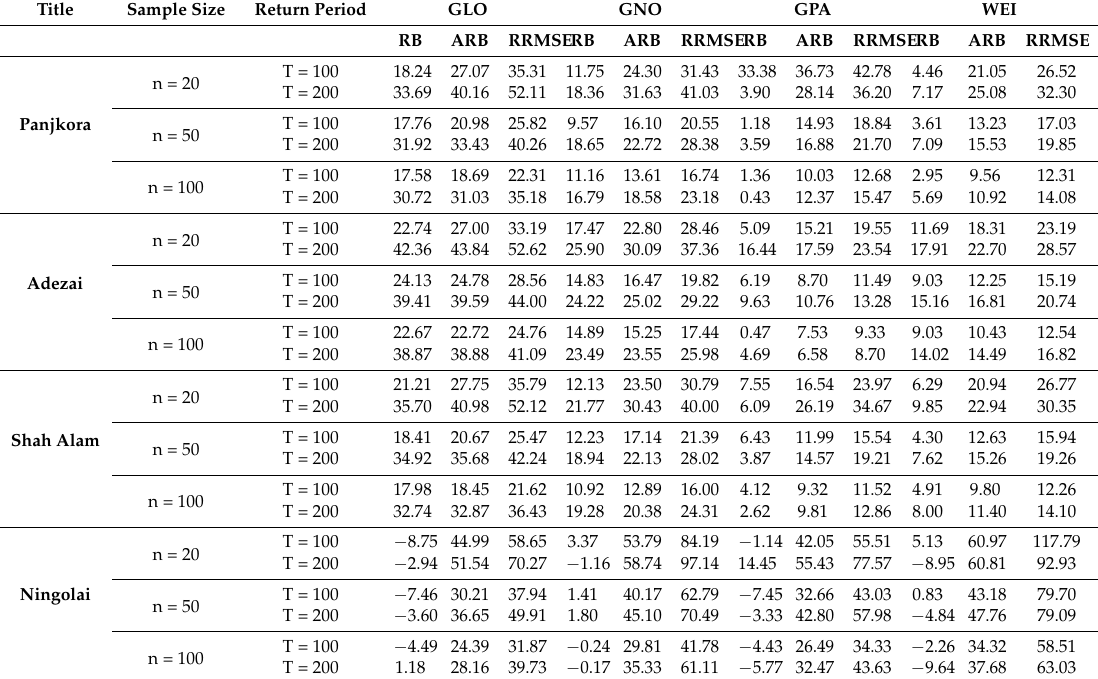
Table 6. Calculated relative bias (RB), absolute relative bias (ARB) and relative root mean square error (RRMSE) values for different probability